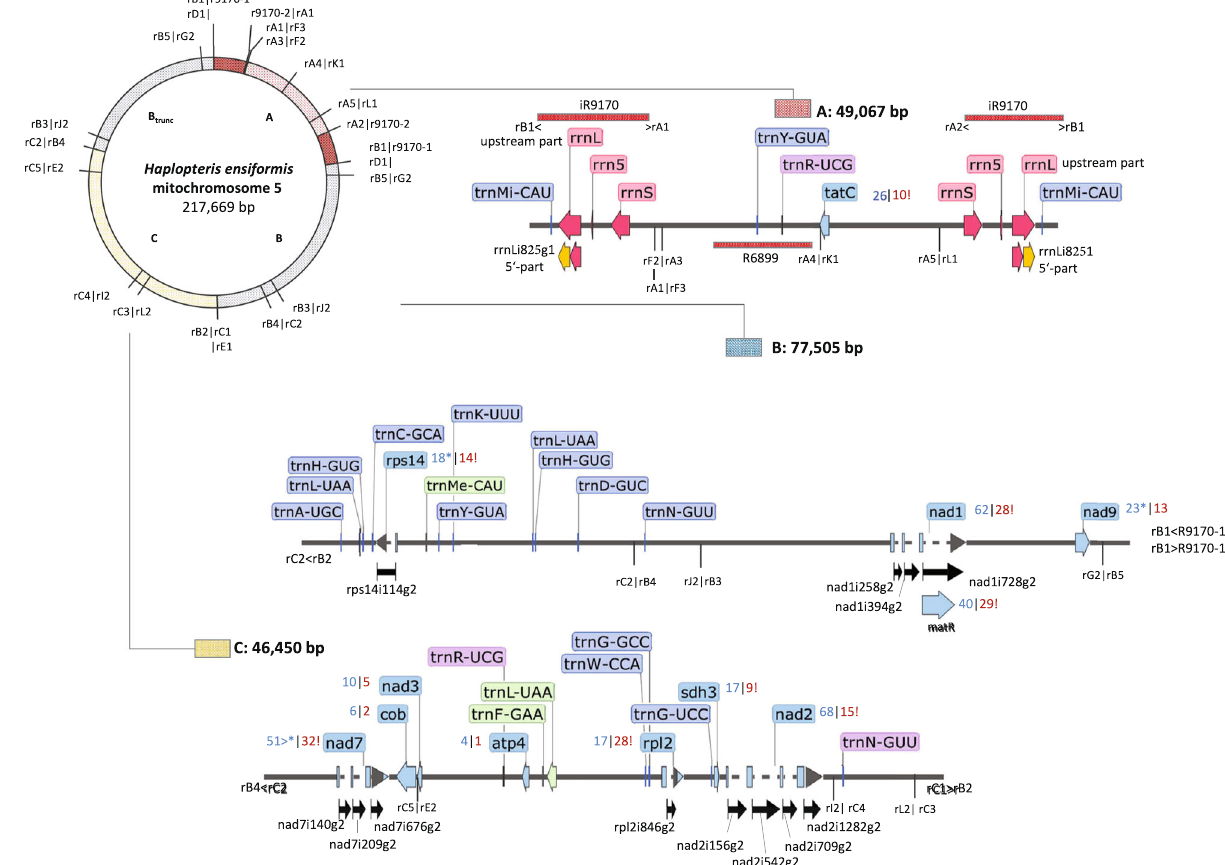
Fig. 2 The Haplopteris ensiformis mtDNA: contigs A-C and chromosome 5. Haplopteris ensiformis mtDNA contigs A (hatched), B (gray), and C (dotted) can be connected into a circular chromosome of 217,669 bp. Recombination breakpoints are numbered for each contig and preceded by a small “ r ” with radial lines in the circular map indicating transitions into other contigs, allowing for numerous alternative mtDNA arrangements. Eight further circular chromosomes, as listed on top, connect sequences of chromosome V with nine further mtDNA contigs D-L as shown in Fig. 3. Contig gene maps were created using the SnapGene Viewer software. Native mitochondrial protein coding and tRNA gene sequence are given in lighter and darker blue, respectively, and introns are indicated with black arrows. Numbers next to genes indicate C-to-U (blue) and U-to-C RNA edits (red) with additional symbols indicating removal (!) or creation of stop (*) or start (>) codons, respectively. Introns are indicated with stippled lines and additional black arrows and their standardized labels. Ribosomal RNA genes (here on contig A) are shown in red with the rrnL gene featuring a complex gene structure requiring trans -splicing via the disrupted group I intron rrnLi825g1 and PSX labels indicate pseudogene fragments shown in gray. The peculiar case of the trans - spliced group I intron rrnLi825g1 is highlighted in yellow. Genes for tRNAs of chloroplast or bacterial origin are indicated in green or purple, respectively. For clarity, no other chloroplast or bacterial DNA insertions are shown here. The latter are listed together with annotated features in Supplementary Data